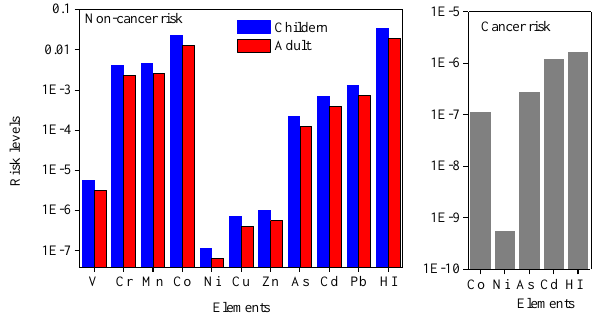
and metals-Fe, 3 Figure 13. Non-cancer and cancer risks for heavy metals raised by intensive firework burning in